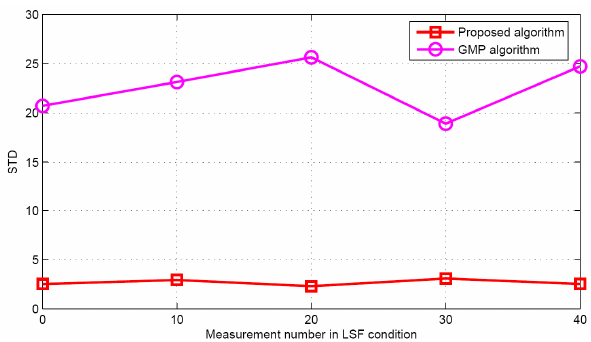
Figure 15. The mean of the estimated population in LSF conditions.